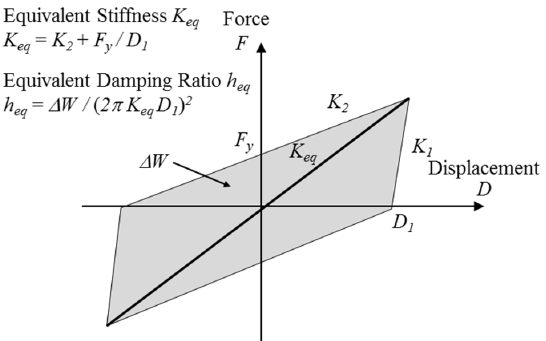
Figure 6. Analytical idealization for the specimen.